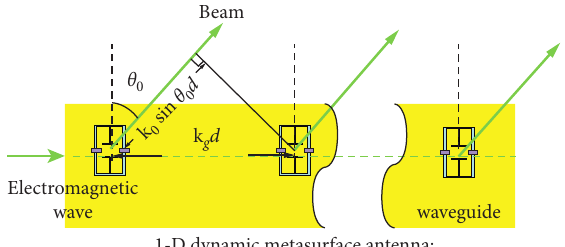
� 10mm; and λ � 6 . 5mm). g 0